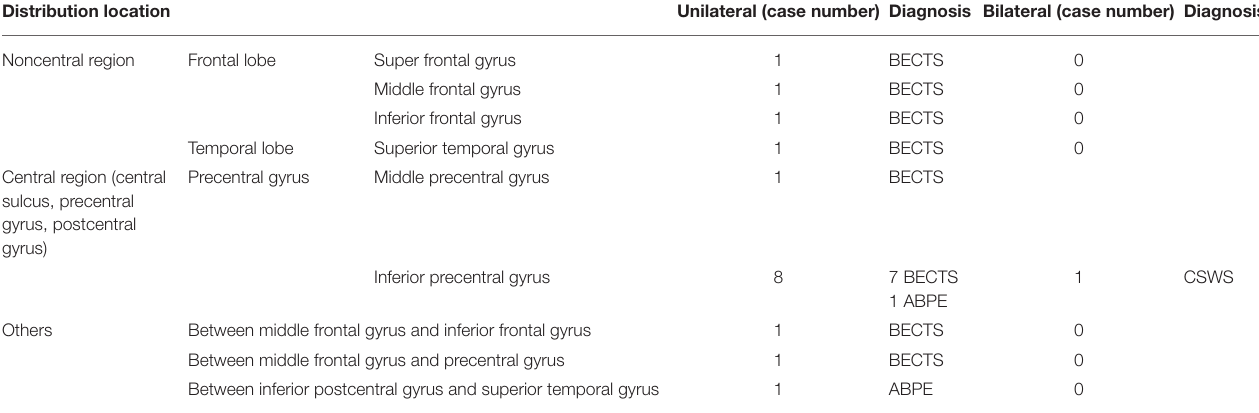
TABLE 3 | Magnetoencephalogram dipole distribution statistics. Distribution